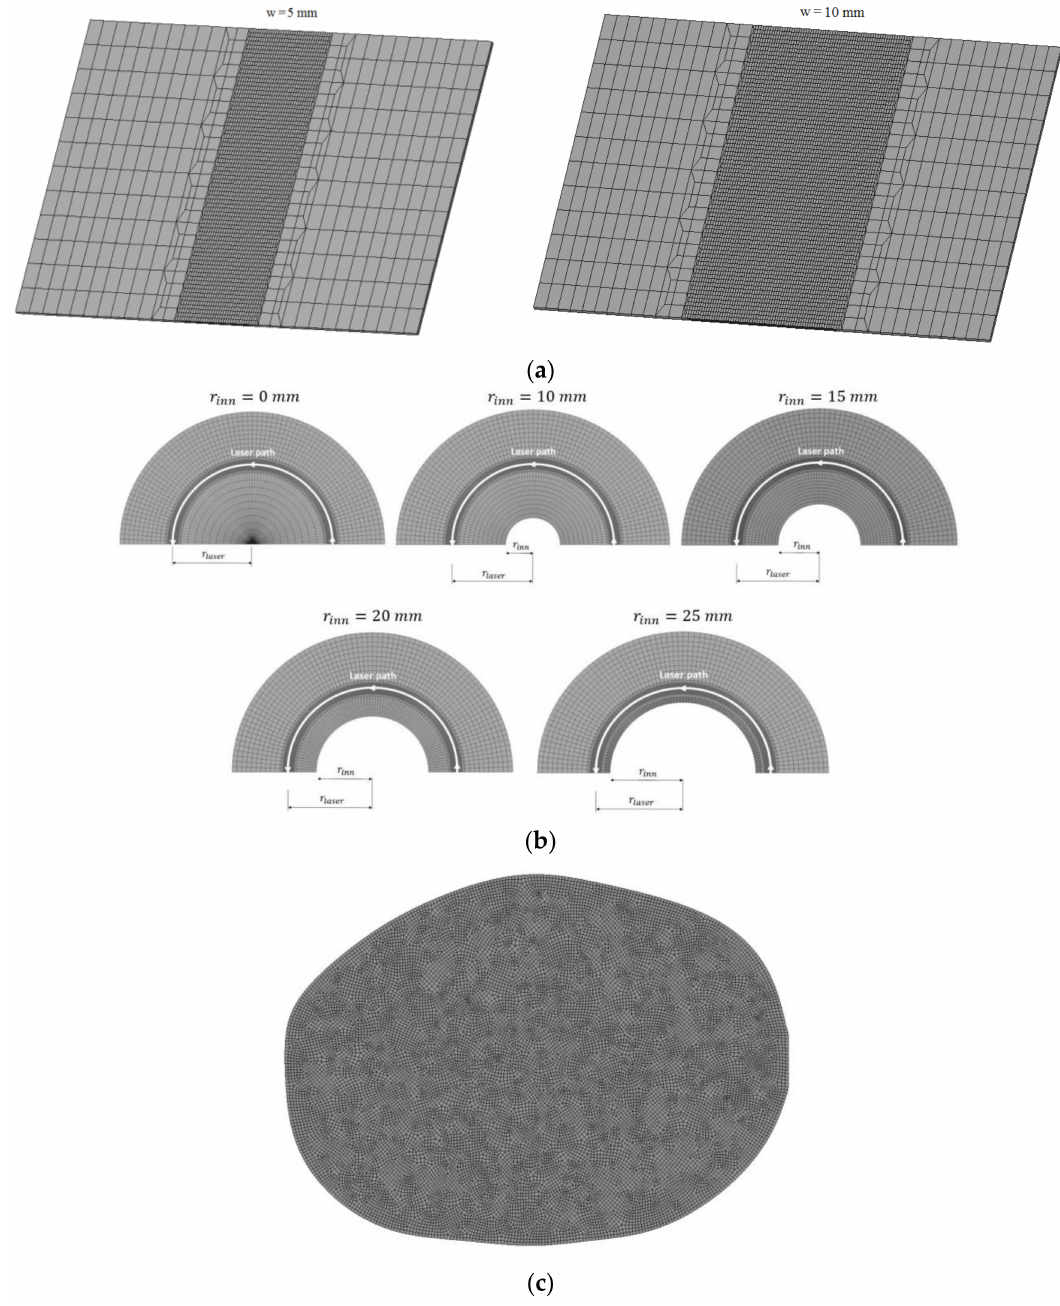
Figure 7. Representative finite element meshes used in the numerical simulations: ( a ) single S-shape, ( b ) multiple circular, and ( c ) single piecewise linear scanning